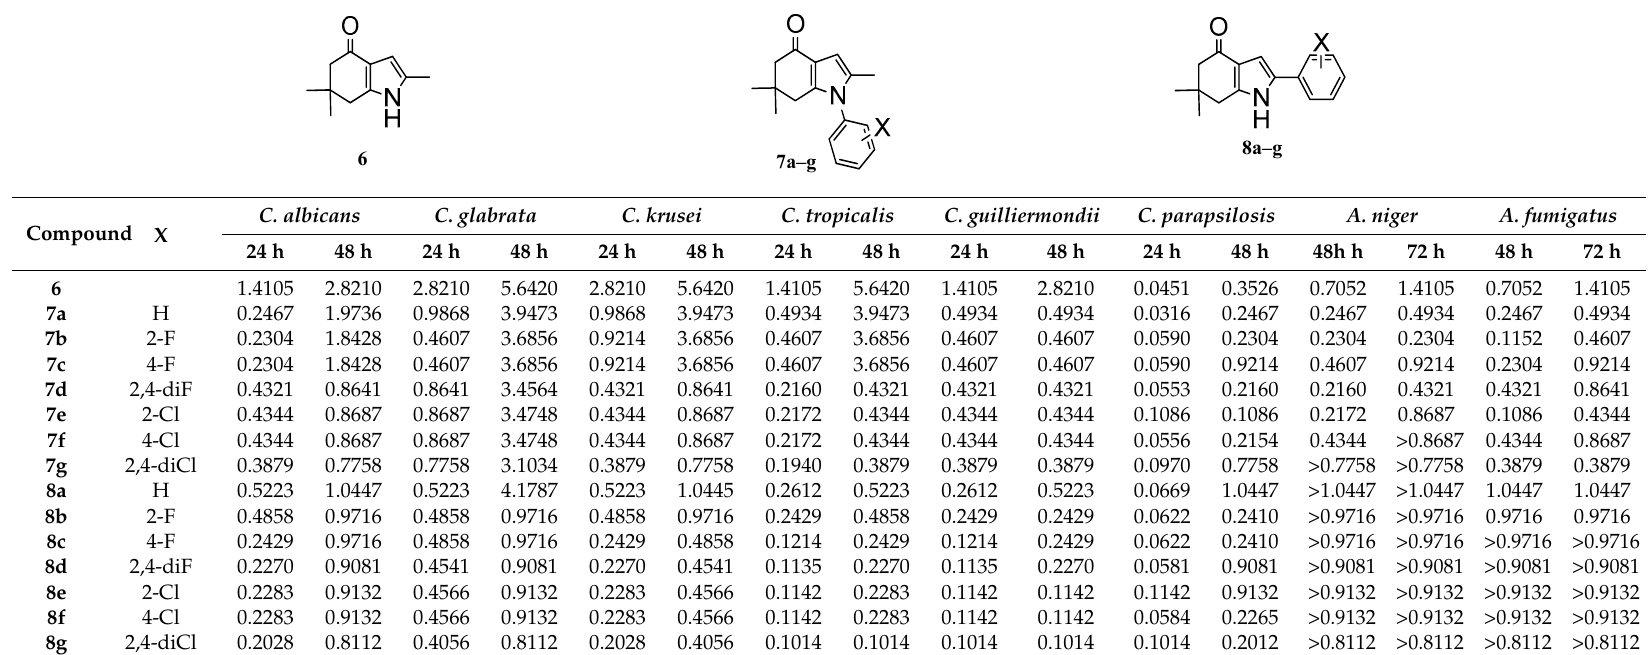
Table 1. MIC in vitro of 6 , 7a – g and 8a – g against yeast and filamentous fungus.